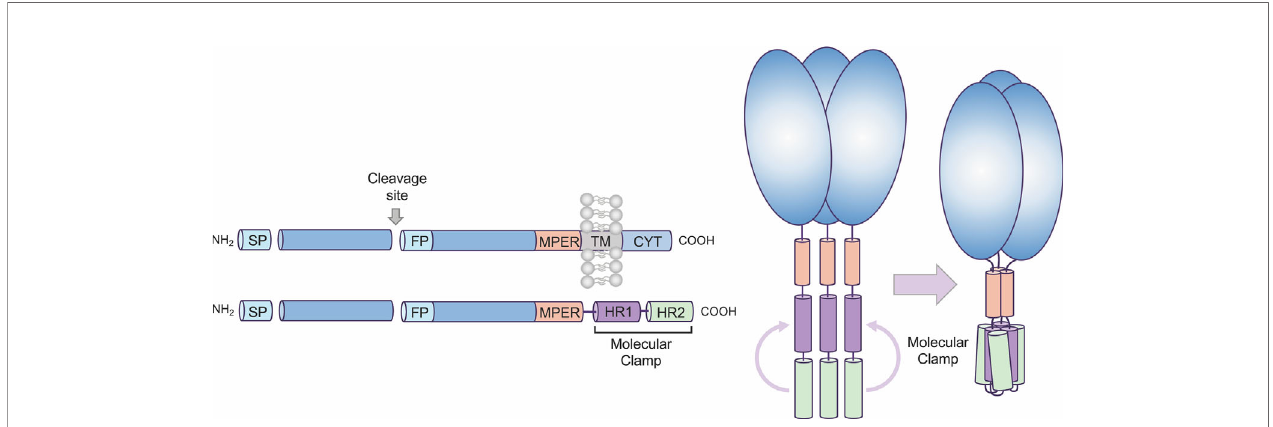
FIGURE 1 | Overview of Molecular Clamp stabilized antigen design. Class I and III viral fusion proteins share common molecular features including a C-terminal transmembrane domain. To generate a soluble, secreted antigen the Molecular Clamp, comprising of hepad repeat (HR) regions 1 and 2 of human immunode fi ciency virus (HIV)-1 glycoprotein 41 (gp41), is incorporated into recombinant viral glycoproteins in place of the C-terminal transmembrane/cytoplasmic region. We have also shown that selected modi fi cations within the signal peptide (SP, replacement with a more ef fi cient SP such as IgK SP), cleavage site/s (ablated or enhanced), fusion peptide (deletion), and deletion of the transmembrane domain adjacent to the membrane-proximal external region (MPER) to introduce the clamp domain can increase expression levels of soluble recombinant